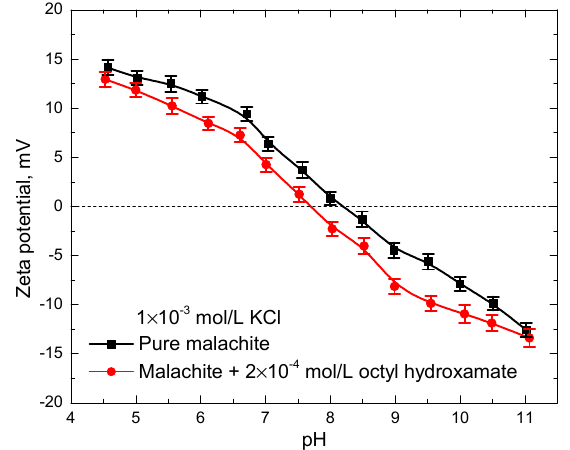
Figure 7. Zeta potential of malachite in the presence and absence of 2 × 10 − 4 mol / L octyl